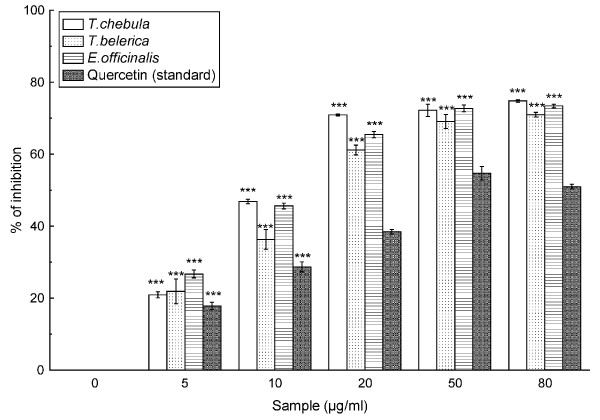
Superoxide radical scavenging assay. Scavenging effect of T. chebula, T. belerica and E. officinalis plant extracts and standard quercetin on superoxide radical. The data represents the percentage of superoxide radical inhibition. All data are expressed as mean ± S.D. (n = 6). ***p < 0.001 vs 0 μg/ml.